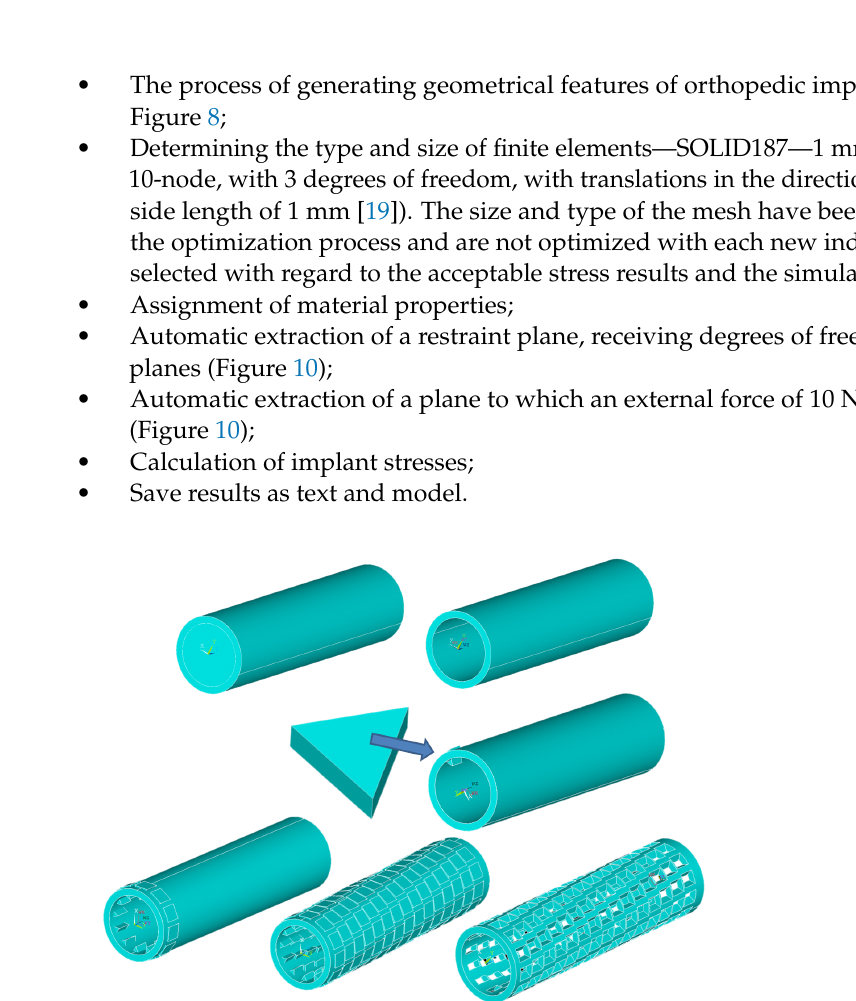
Figure 8. The process of generating geometrical features of orthopedic implants.